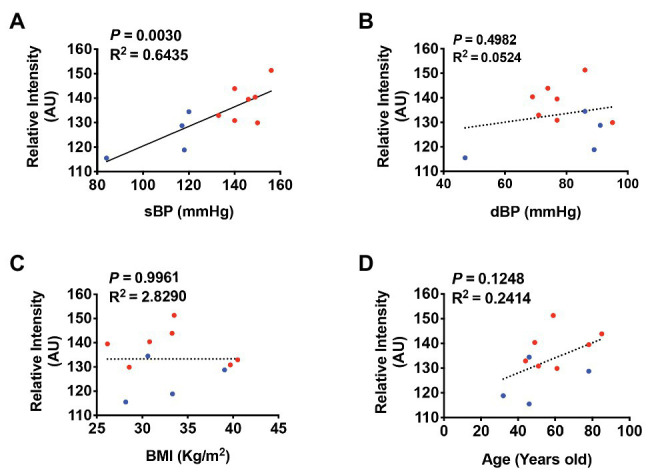
PRR immunoreactivity is positively correlated with sBP in the PVN of the human brain. A least-square correlation post analysis was used to calculate the correlation between the relative intensity of PRR immunoreactivity and systolic BP (sBP; A), diastolic BP (dBP; B), body mass index (BMI; C), and age (D). N = 11.